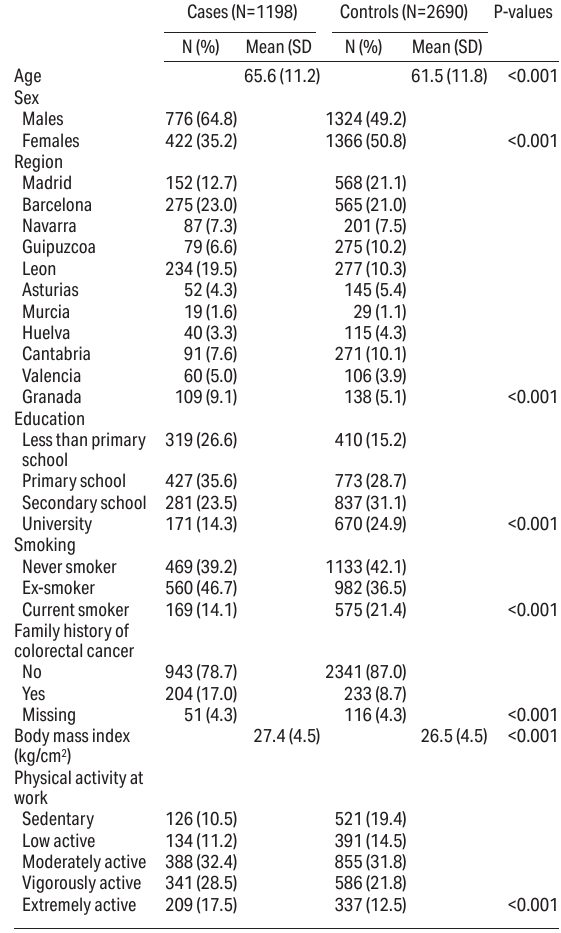
Table 1. Distributions of risk factors among colorectal cancer cases and controls. [SD=standard deviation]. Wilcoxon rank-sum for con- tinuous and chi-square for categorical. Numbers may differ due to missing